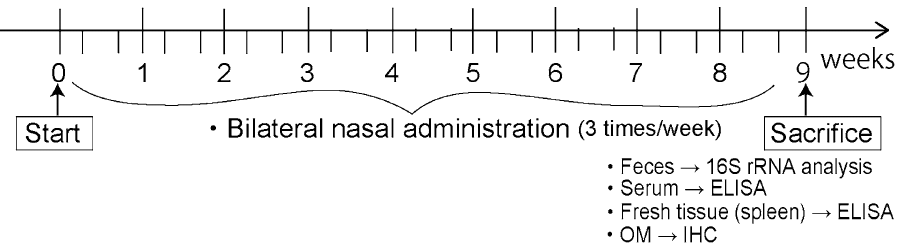
Figure 6. Experimental protocol. Mice received repeated bilateral intranasal administration of LPS or saline 3 times per week and were sacrificed at 9 weeks after the first administration. Feces, blood, fresh tissue of spleen were obtained for 16S rRNA and ELISA analyses. Olfactory mucosa (OM) was used for histological